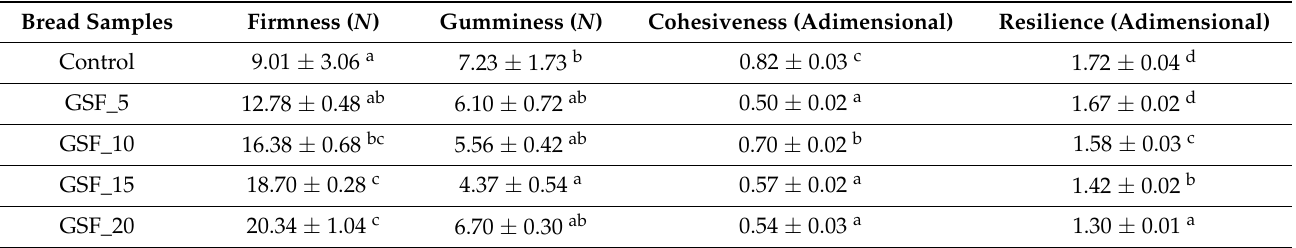
Figure 3A. From Table 6, it may be observed that at 10% GSF addition the pore size started to increase slightly but then decreased when 15% and 20% GSF were incorporated into the bread recipe. Table 5. Texture parameters of the bread with different proportions of GSF supplementation in wheat flour.